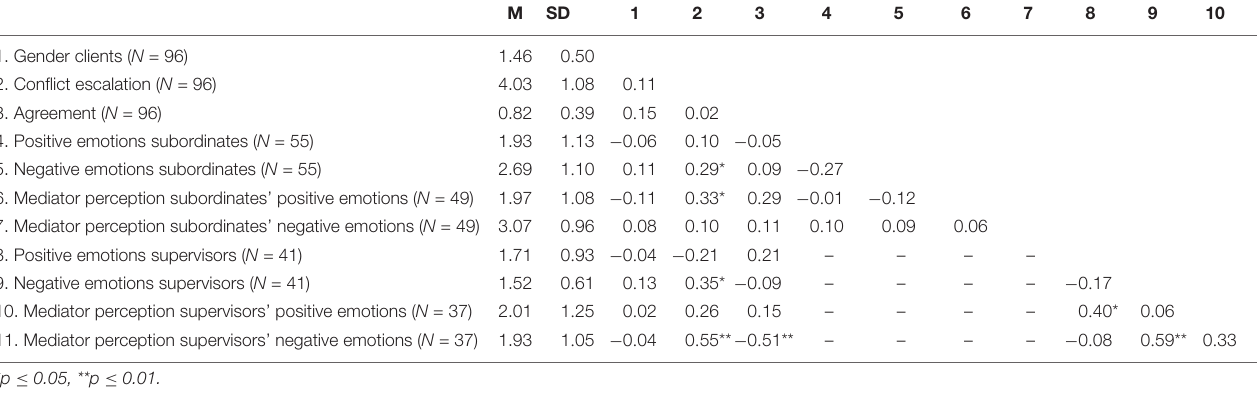
TABLE 1 | Means (M), standard deviations (SD), and correlations between parties’ positive emotions, negative emotions, mediator emotion perception and control variables.